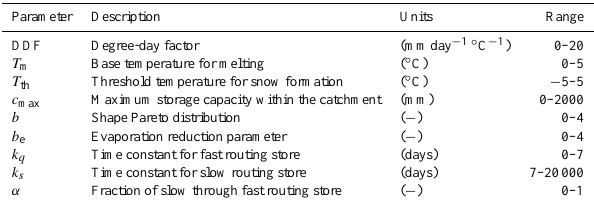
Table A1. Conceptual model prior parameter